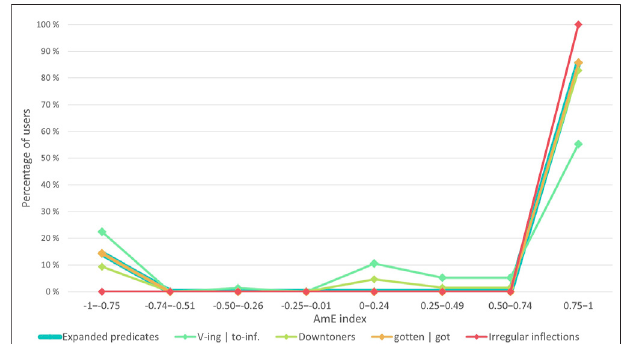
FIGURE 8 | The distribution of users ’ AmE indexes at the level of individual grammatical